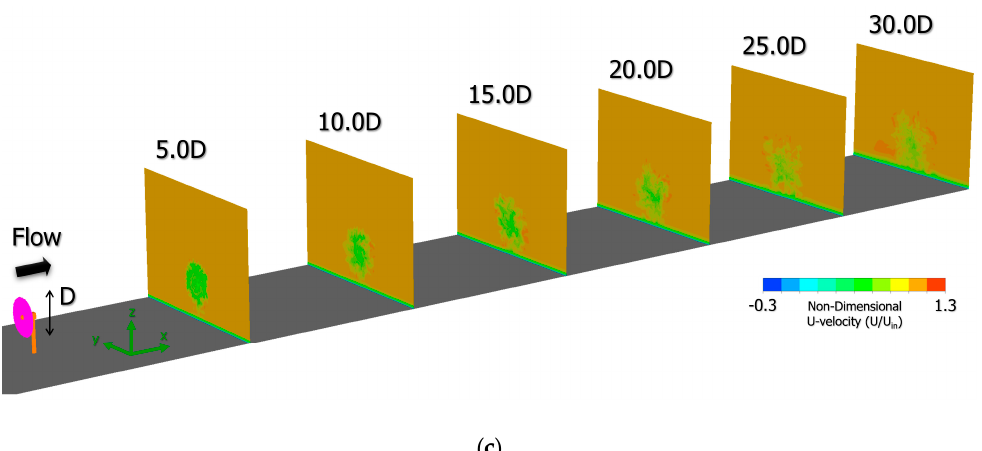
Figure 17. Spatial distribution of U-velocity for instantaneous flow field in the y–z plane (front view). at x = 5.0 D, 10.0 D, 15.0 D, 20.0 D, 25.0 D, and 30.0 D: ( a ) N = 4, ( b ) N = 10, and ( c ) uniform flow.